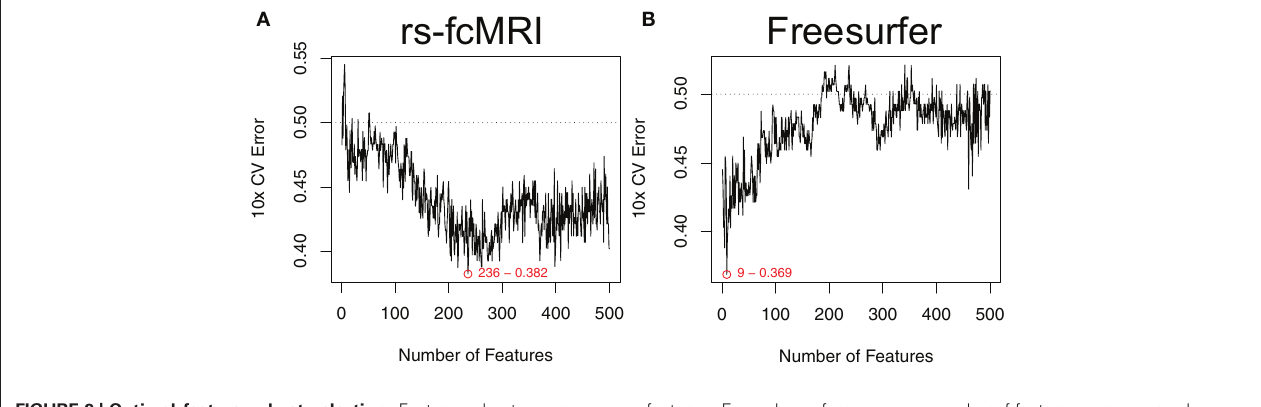
features. Example performance vs. number-of-features curves are shown for raw rs-fcMRI connectivity matrix data (A) and Freesurfer morphological data (B) . Example data were drawn from the NYU site. Plots are annotated with the optimal number of features and the associated expected generalization